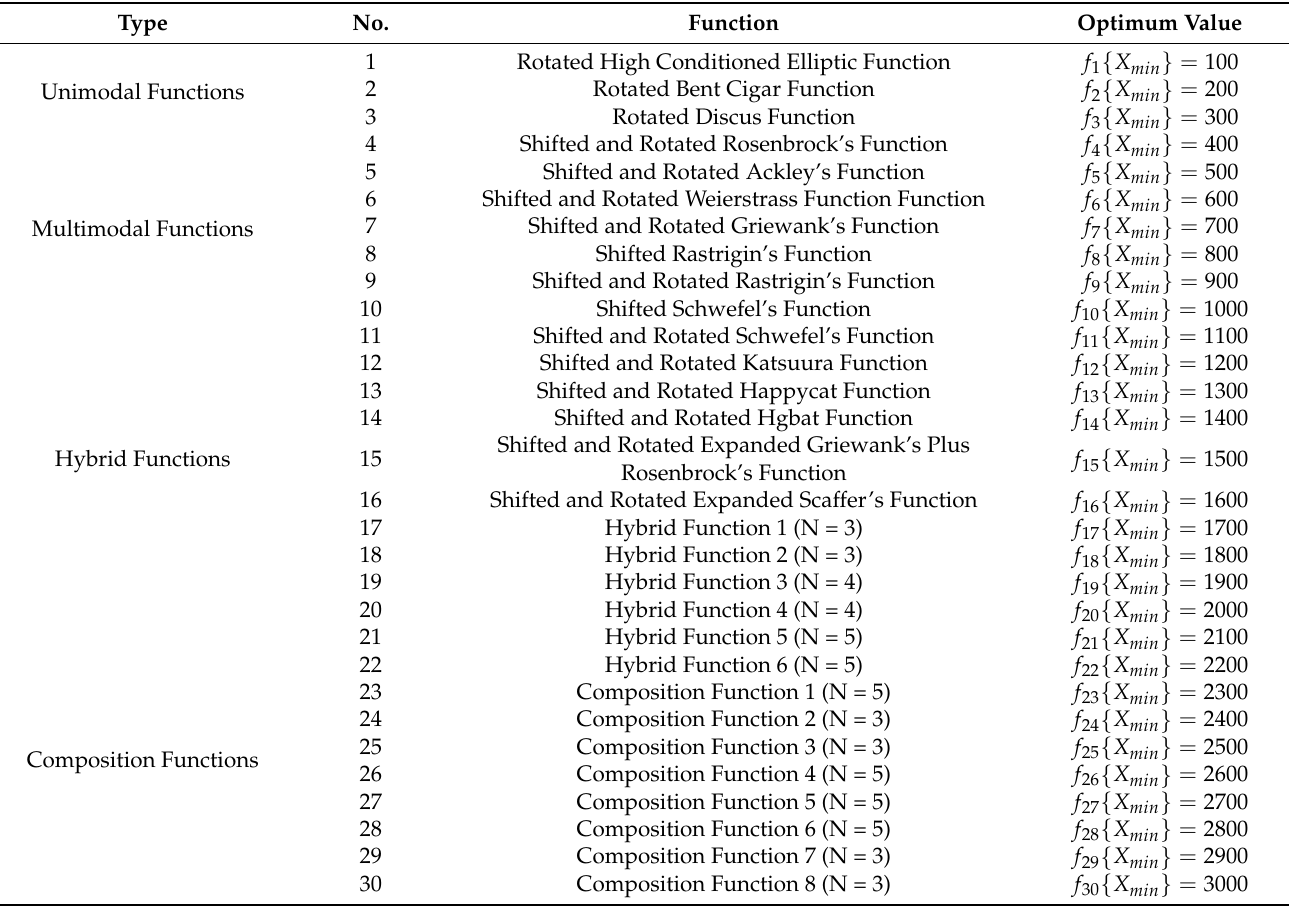
Table A1. Summary of the CEC2014 benchmark problem